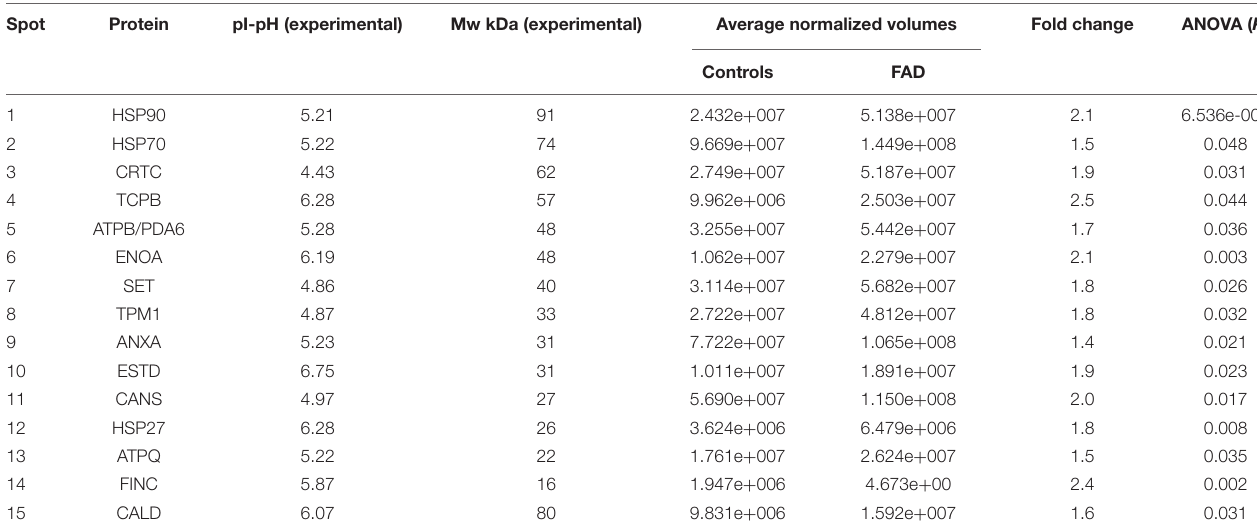
FIGURE 5 | Changes in protein expression in fibroblasts from FAD patients (AD1 and AD2) and fibroblasts from control individuals (NA2 and NA3). Proteins were separated by molecular weight and isoelectric point using 2-DE gels. (A) Scanned images of the 2-DE gels developed with Coomassie blue; 2 biological replicates and 2 experimental replicas are presented. (B) Representative image of the 68 spots (red) with significant differences reported by SameSpot software, of which 15 proteins were identified by reference proteomic maps derived from fibroblasts. The analysis of expression is presented in Table 4 . TABLE 4 | Spots identified in the 2-DE gels of FAD fibroblasts and